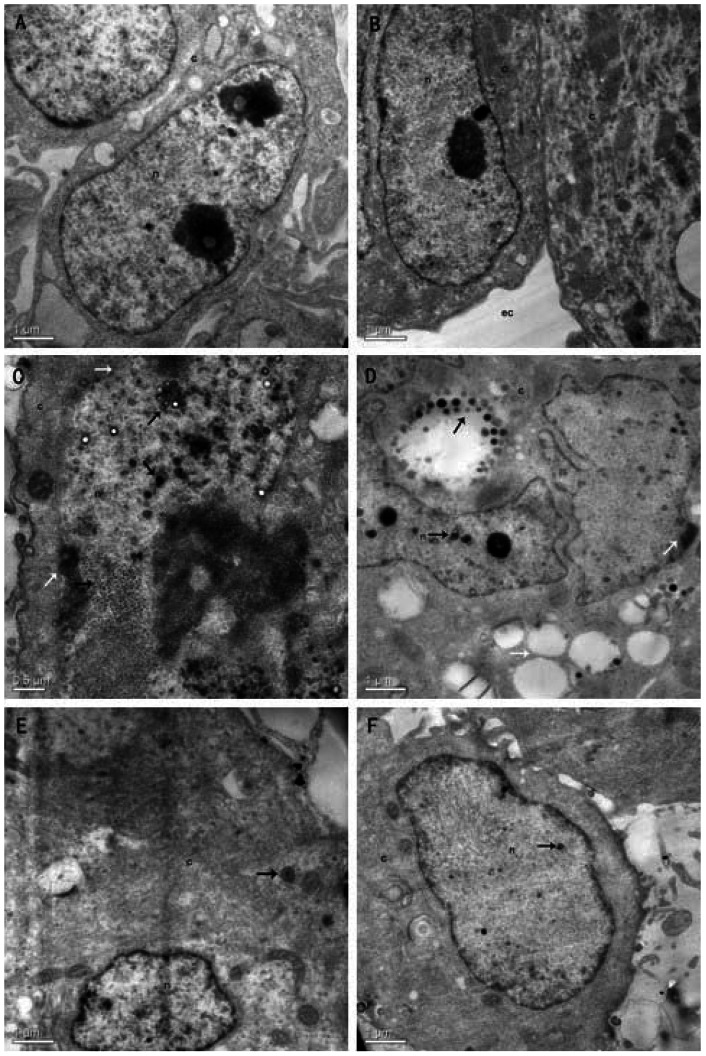
Inhibition of viral replication studied by TEM.DEFs were infected (C, D, E and F, MOI  = 0.1) or infected (A and B) with DEV in the absence (A, B, C and D) or presence (E and F) of 31.25 μg/mL of resveratrol. At 48 h p.i., the replication of DEV in DEFs were studied by TEM. Pictures were taken using a Tecnai G2 F20 electron microscope (FEI, USA). (A and B): normal appearance of cell nucleus and cytoplasm. (C): DEFs infected with DEV. ↗: viral capsids in nucleus; →: a massive accumulation of virus nucleic acids in nucleus; <$>\scale 80%\raster="rg1"<$>: mature viral particles in nucleus; white arrows ↗: chromatin margination; white arrows →: nucleolus membrane burst). (D): DEFs infected with DEV. (↗: Maturating and mature particles in cytoplasmatic vacuoles; →: Maturating particles in nucleus; white arrows ↗: chromatin margination; white arrows →: an extensive vacuoles degeneration). (E and F): Infected DEFs treatment with resveratrol. (→: few viral particles were observed in nucleus and cytoplasm). n: nucleus; c: cytoplasm; ec: extracellular space.